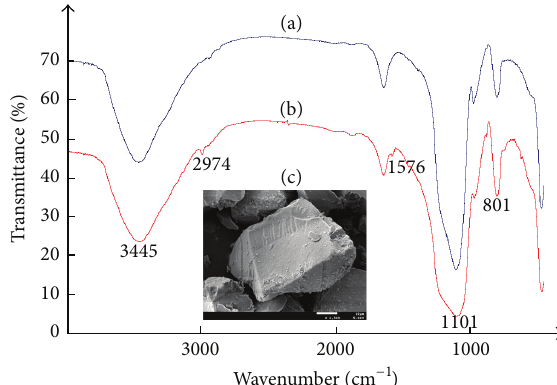
Figure 4: IR spectrum of blank silica gel (a) and SIL (b) together with SEM of SIL